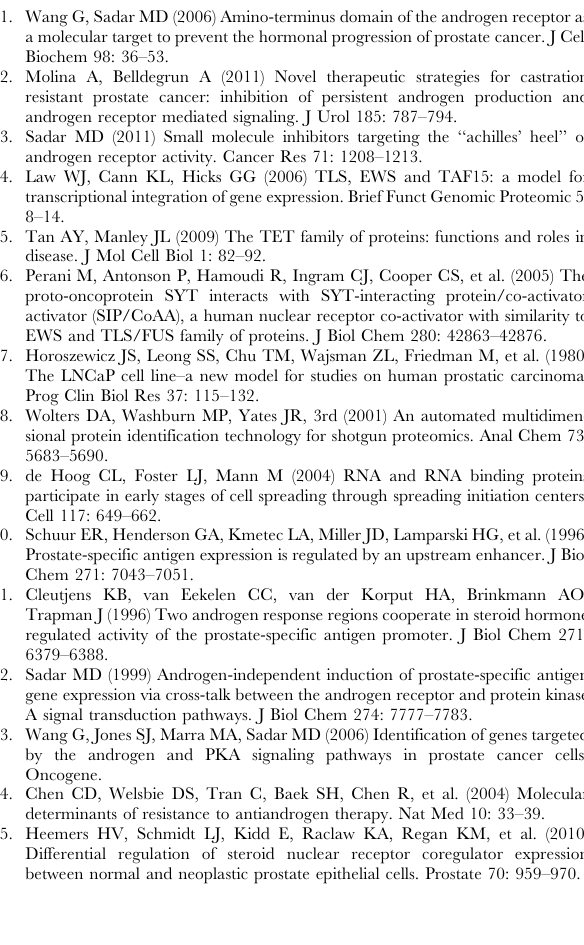
Figure S4 Comparative analysis of FUS expression in clinical samples from various cancer types. Data from a previous study is mined using